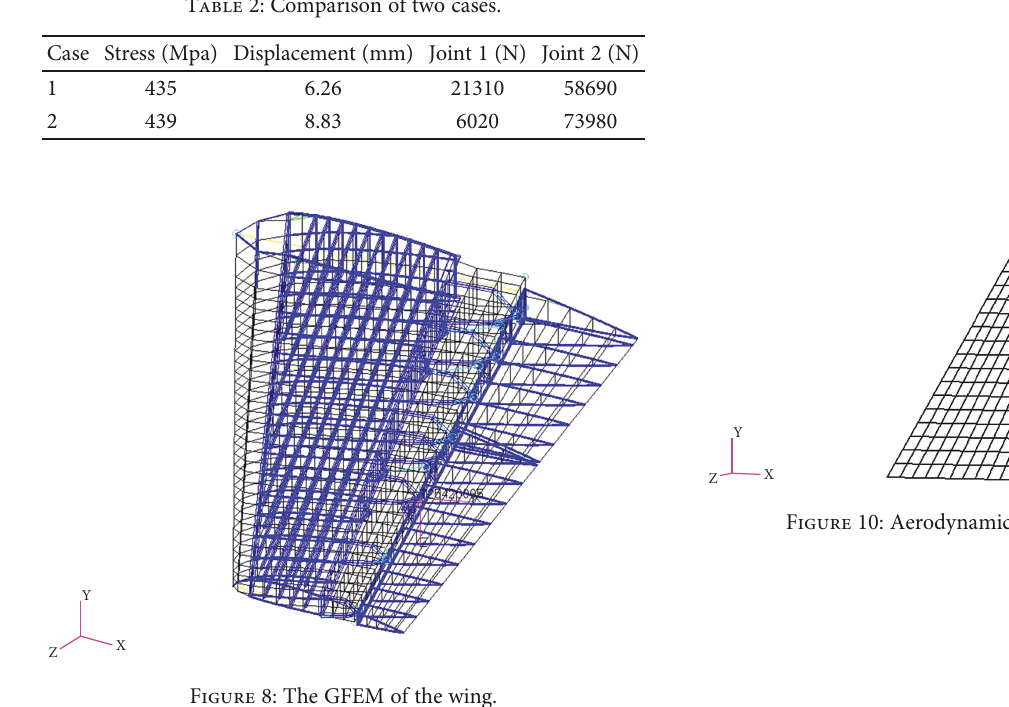
Figure 8: The GFEM of the wing.